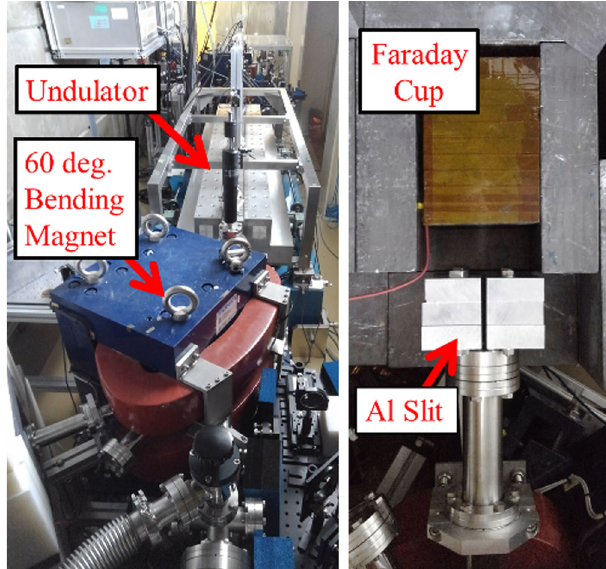
FIG. 2. Photographs of the Faraday cup, aluminum slit, bending magnet, and